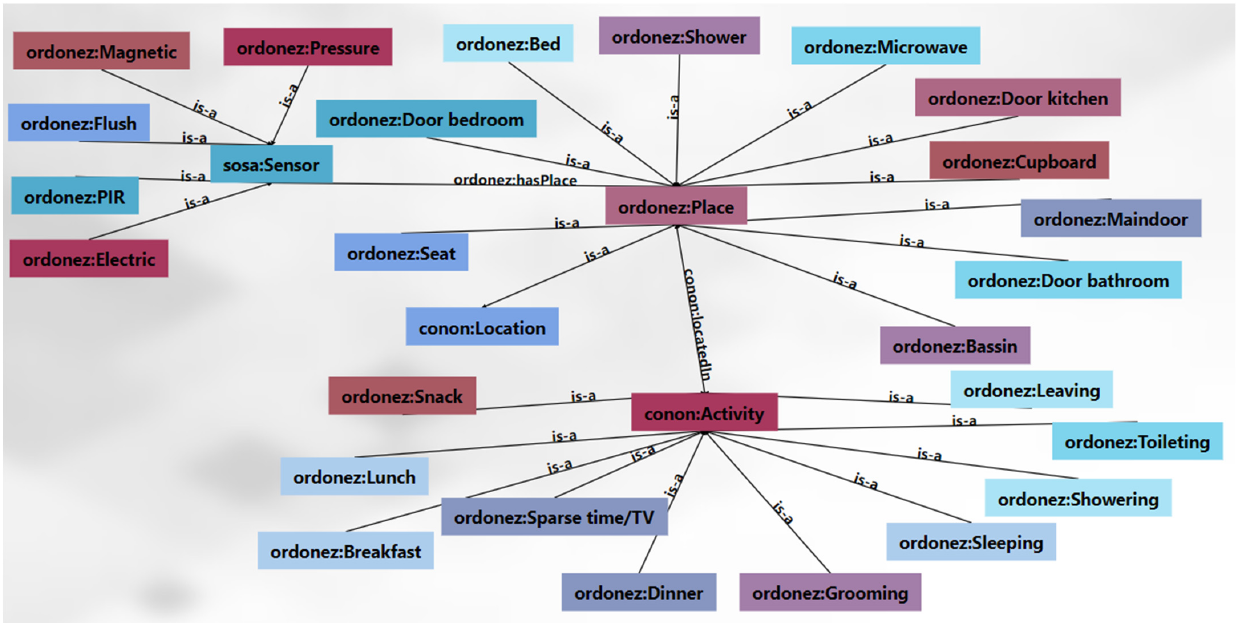
Figure 10. Ontology-based model evolution at t 1 , showing an excerpt of the evolved ontology-based model at t 1